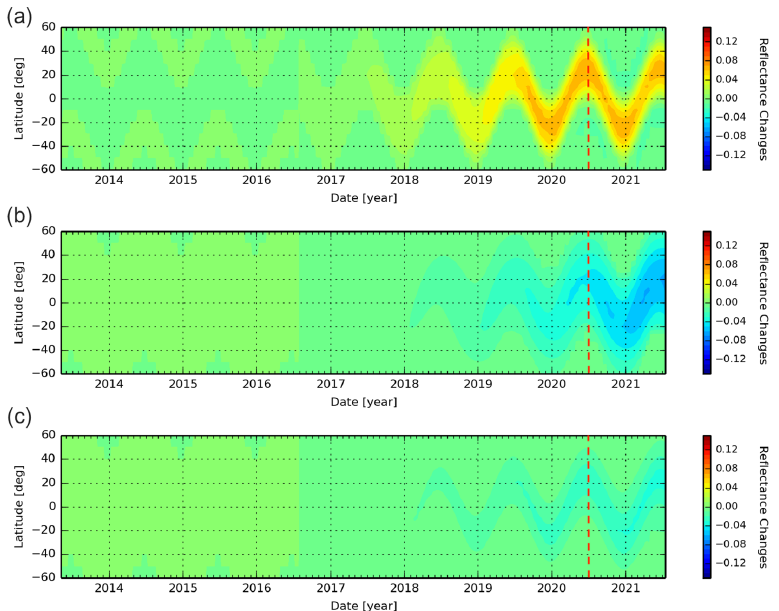
Figure 5. The figure shows simulated changes of synthetic surface reflectances, with respect to a fixed sun-synchronous orbit at 10:45 a.m. Changes are plotted for the NIR band as a function of date and latitude. Three plots are shown for three angular configurations corresponding to the viewing angle in the three Proba-V cameras: ( a ) left, ( b ) nadir and ( c ) right. The end of Proba-V Operational Phase (30 June 2020) is plotted as a dashed red line.